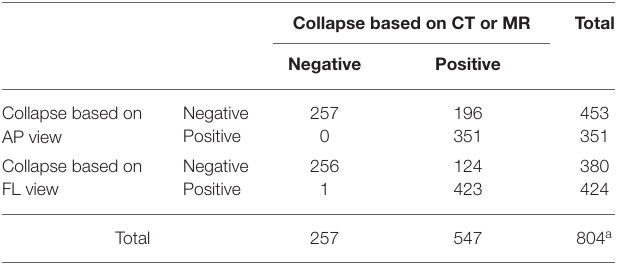
TABLE 4 | Comparation between standard radiograph without crescent sign and golden